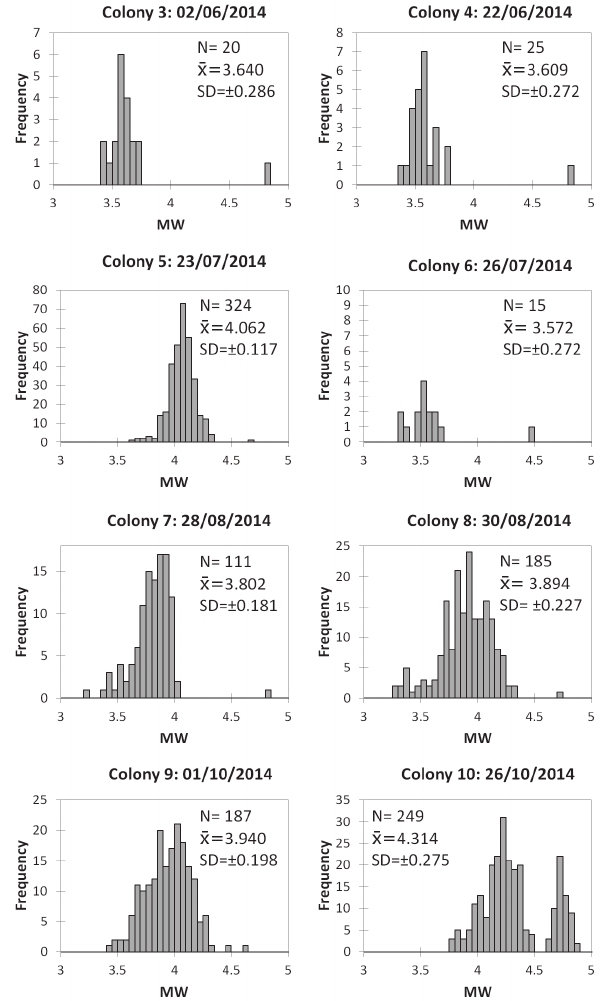
Figure 1. MW histograms. Histograms showing MW (mesoscutum width) from eight different colonies, sorted by collection